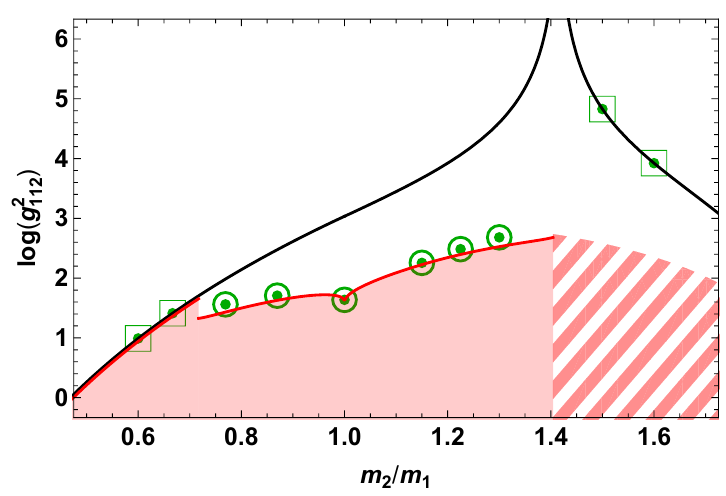
Figure 12. The green data points show the maximal values of log( g 2 ) provided by the multi- 112 correlator QFT in AdS analysis, now for (cid:11) = g 222 =g 112 = 1 and as a function of the mass ratio (cid:0) m 2 =m 1 . For comparison we have also added the single-correlator QFT in AdS bounds from [1], as solid lines, as well as the S-matrix bootstrap data, in red. The plot naturally splits into three regions. First of all, for m 2 =m 1 < 1 = p 2 there is screening and the multi-amplitude bound reduces to the single-amplitude bound. As shown, the correlator bounds nicely follow this behavior. Moving rightward, for 1 = p 2 < m 2 =m 2 < p 2 we (cid:12)nd a respectable match between the multi-correlator and the multi-amplitude data, in particular we again recover the three-state Potts (cid:12)eld theory at m 2 = m 1 . For p 2 < m 2 =m 1 there are Landau singularities and the multi-amplitude analysis becomes complicated. However we know that the multi-amplitude bound must lie at or below the single-amplitude bound from S forward , meaning that it must end up somewhere in the striped 12 12 ! region. The multi-correlator analysis, on the other hand, appears unable to improve on the weaker 1111 single-correlator h i